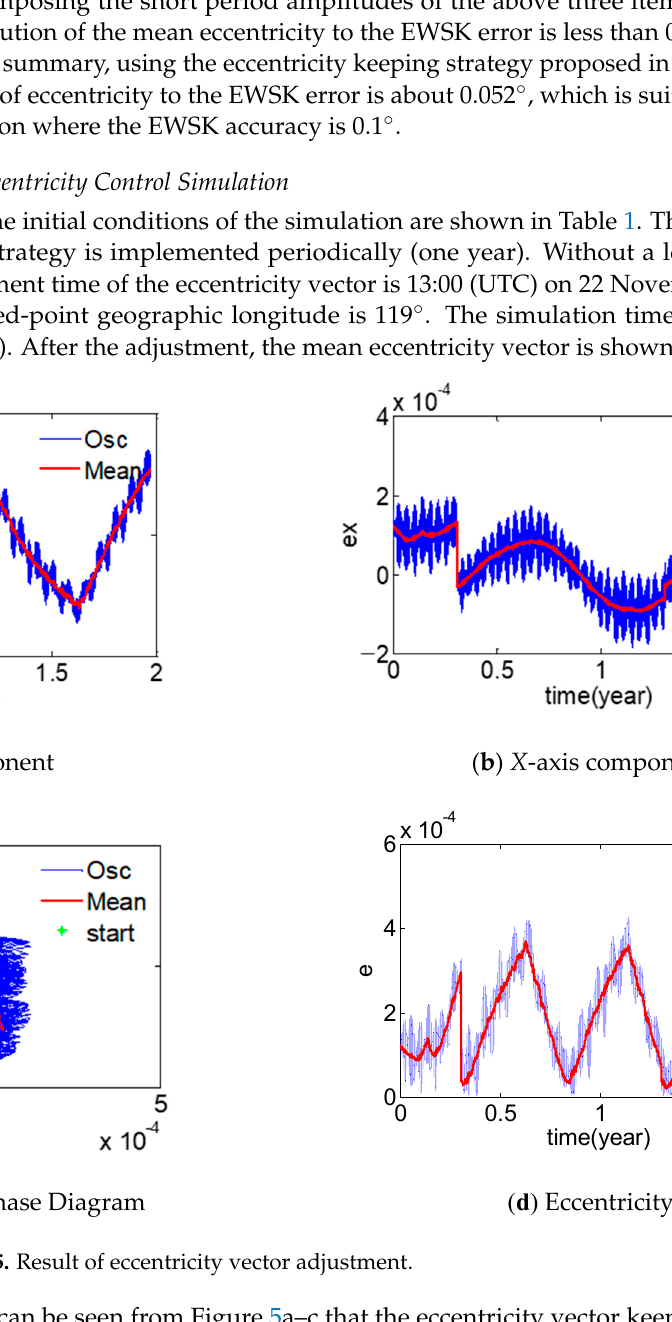
Table 1. Initial orbit used for simulation .